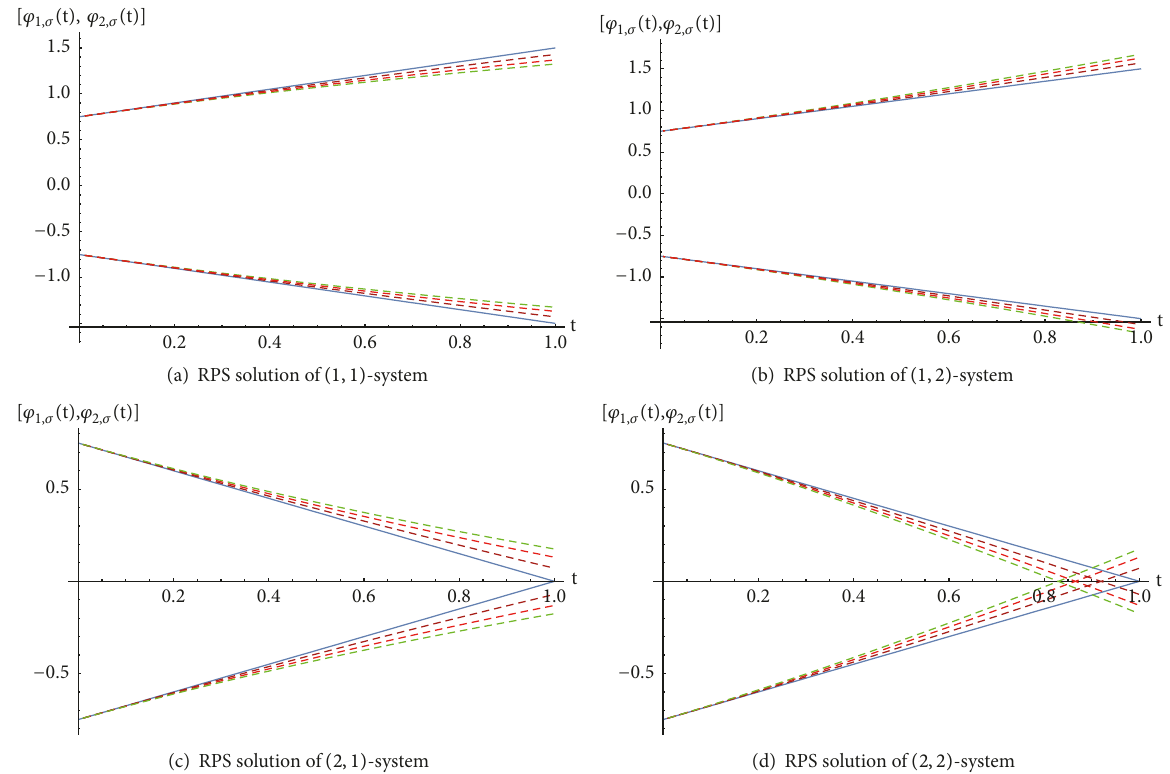
Figure 1: Plots of 𝛼 -cut representations of 𝜑 𝑘,1𝜎 (𝑡),𝜑 𝑘,2𝜎 (𝑡) with 𝑘 = 10 , 𝜎 = 0.25 , and different values of 𝛾 ∈ {2,1.9, 1.8, 1.7} (--- Exact, ⋅ ⋅ ⋅ RPS-approximation).